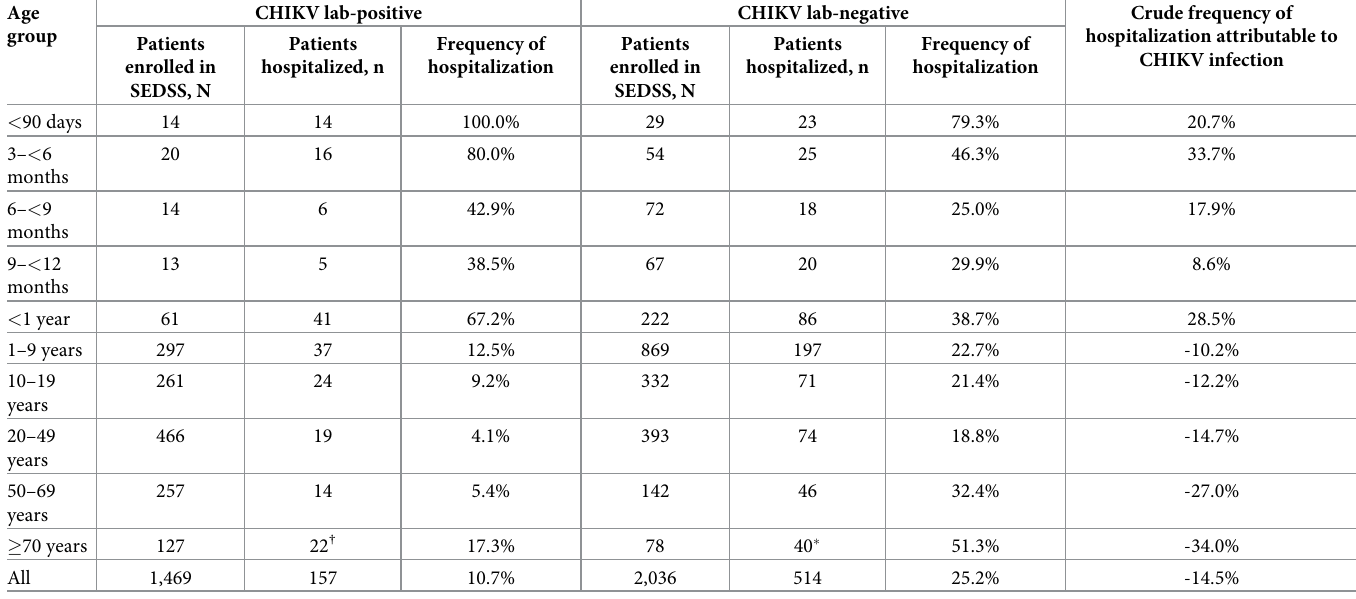
Table 1. Crude frequency of hospitalization attributable to chikungunya virus infection among patients with acute febrile illness enrolled in the Sentinel Enhanced Dengue Surveillance System, 2014. Age CHIKV lab-positive CHIKV group